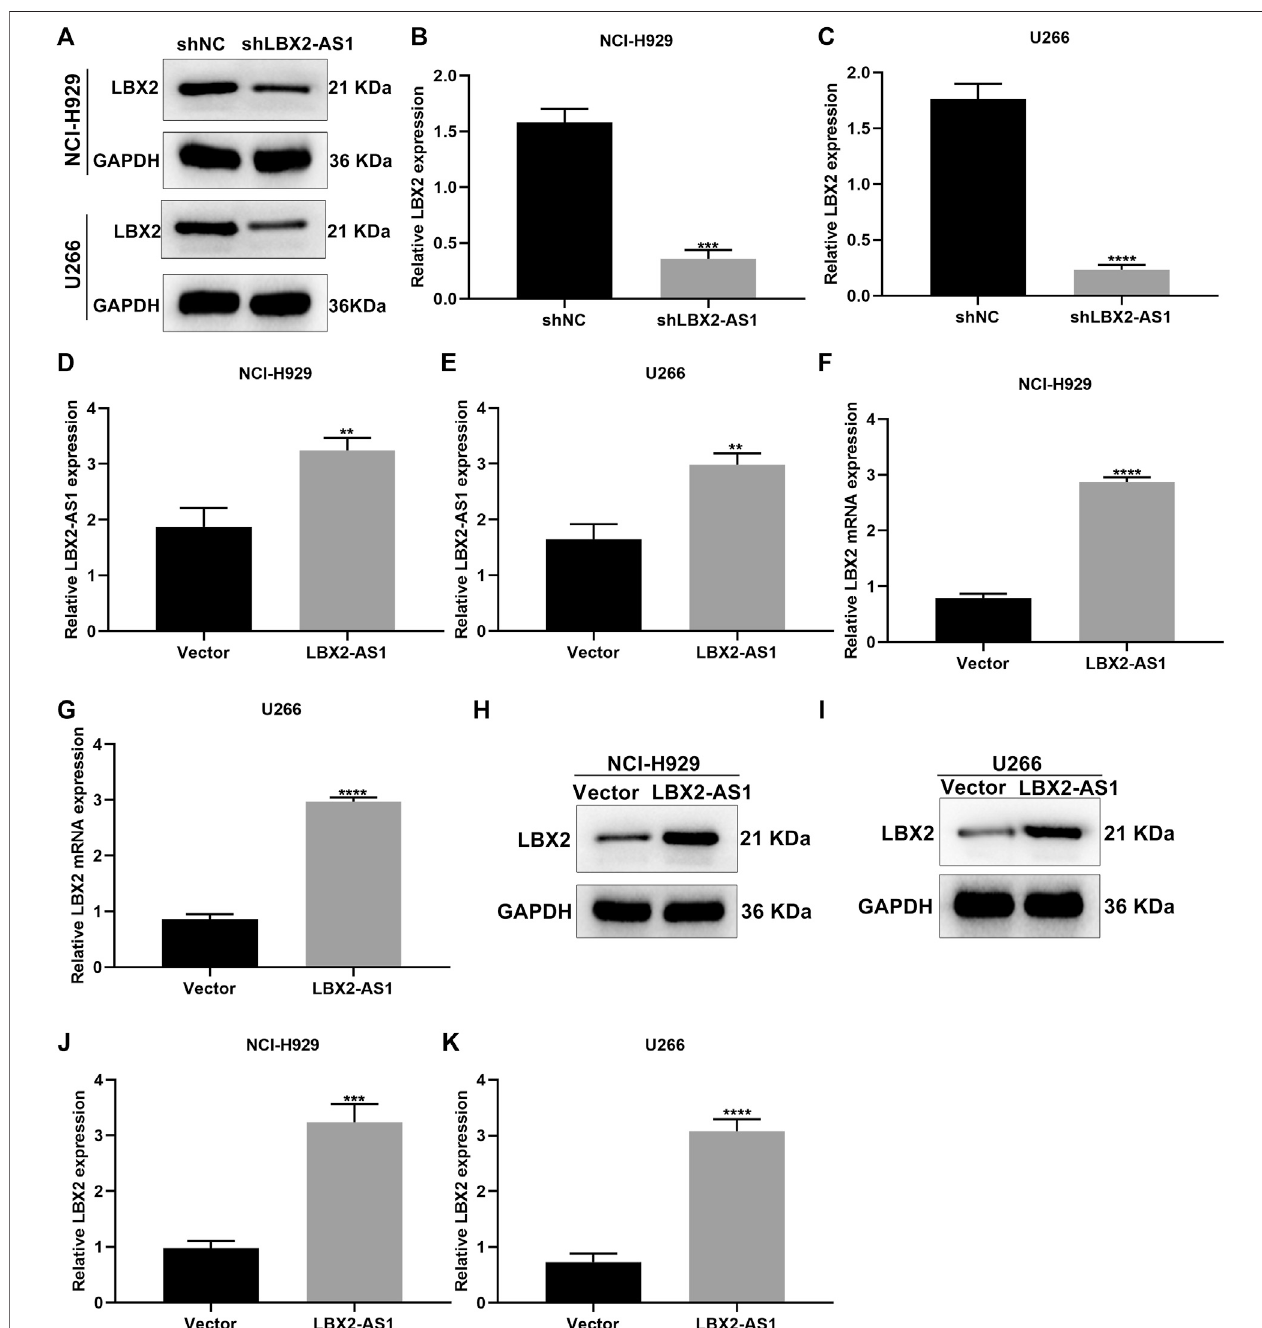
FIGURE5| Up-regulationofLBX2-AS1elevatesLBX2expressioninMMcells. (A – C) WesternblotfortheexpressionofLBX2proteininNCI-H929aswellasU266 cells under transfection by shNC or shLBX2-AS1. (D, E) The transfection effects of pcDNA3.1-LBX2-AS1 and empty vector in MM cells via RT-qPCR. (F, G) The expression ofLBX2mRNAinMMcellsundertransfectionbyemptyvectorandpcDNA3.1-LBX2-AS1throughRT-qPCR. (H – K) WesternblotfortheexpressionofLBX2 protein in MM cells under transfection by empty vector and pcDNA3.1-LBX2-AS1. ** p < 0.01; *** p < 0.001; **** p < 0.0001.